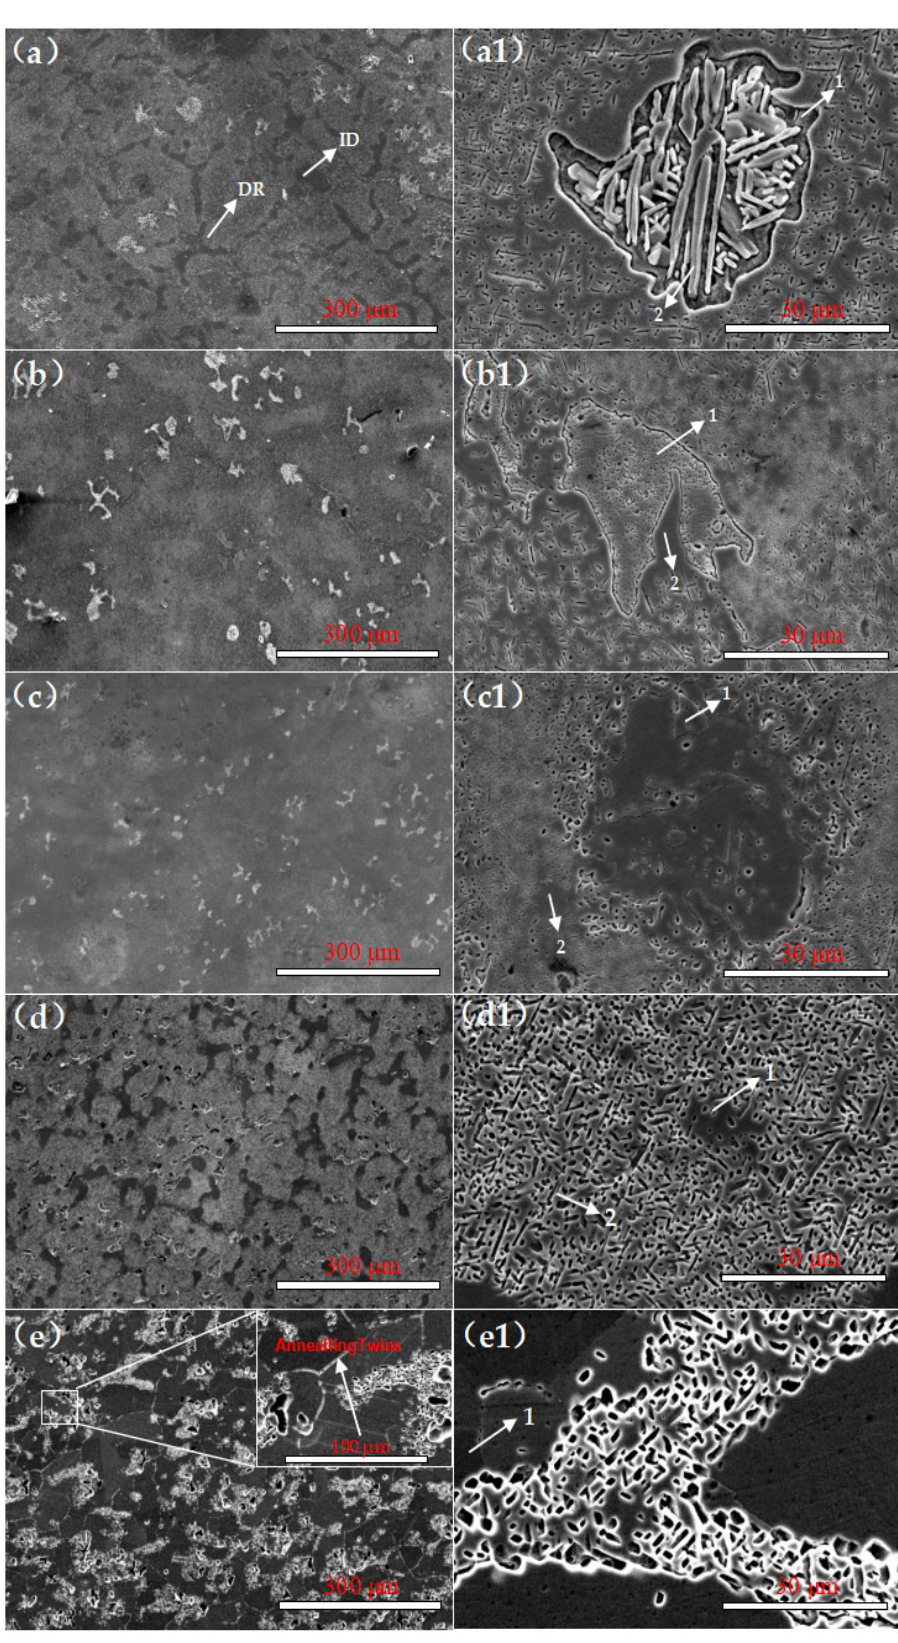
Figure 3. Microstructure and morphology of cast FeCrMnNi alloys and after heat treatment ( a , a1 ) as-cast ( b , b1 ) 700 °C ( c , c1 ) 800 °C ( d , d1 ) 900 °C ( e , e1 ) 1000 °C.